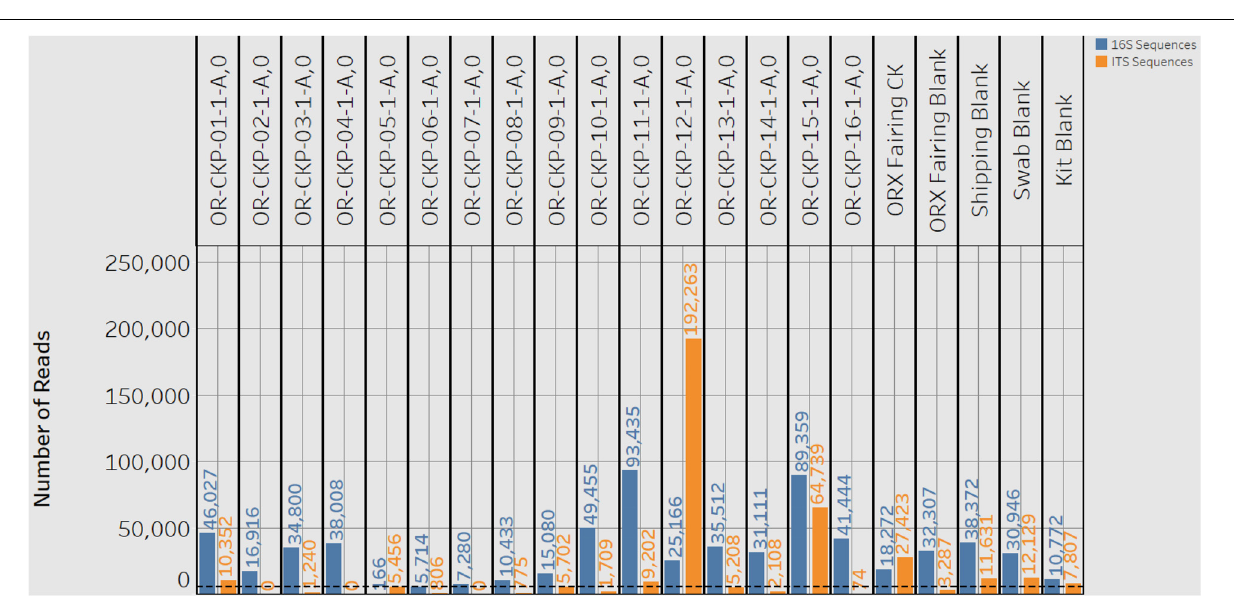
FIGURE 3 | A plot showing the number of 16S rRNA gene (blue bars) and ITS (orange bars) reads or sequences for each sample. A black dashed line marks the detection limit for 16S rRNA gene sequences of 5,611 sequences. One 16S rRNA gene sample (CKP-05) and nine ITS samples fell below this limit of